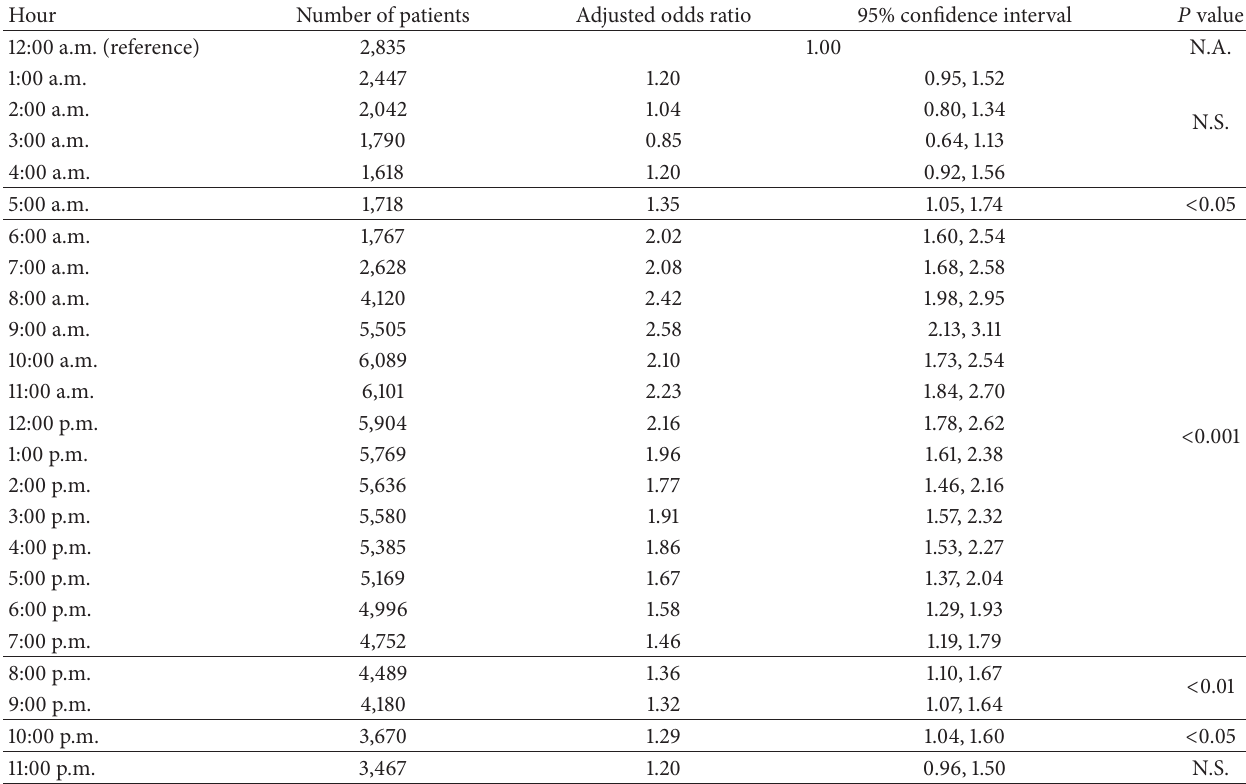
Table 1: Adjusted odds ratio of HIV testing by hour of patient admission to the ED.